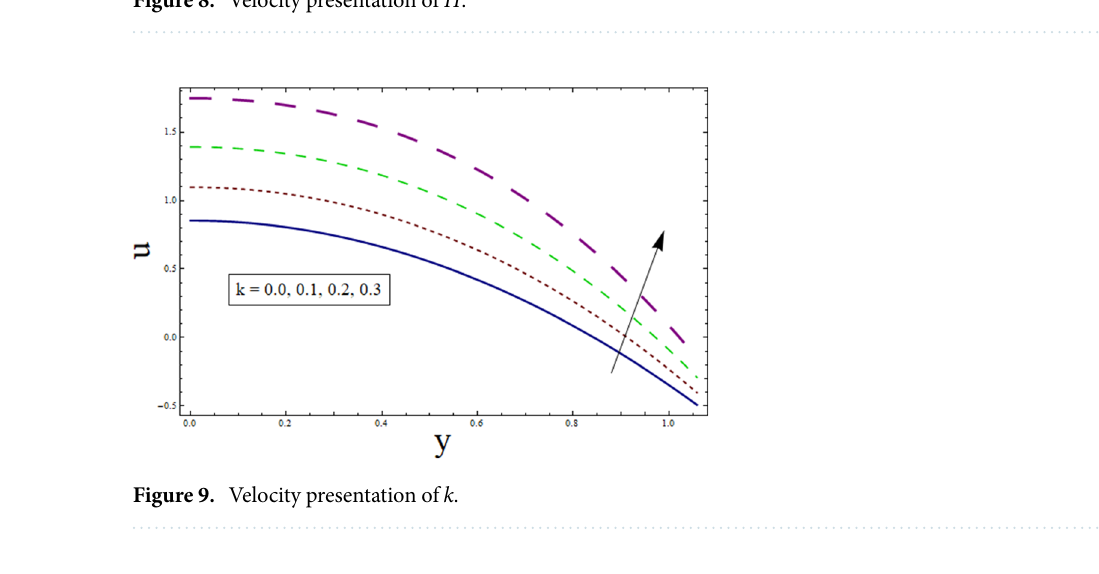
Figure 8. Velocity presentation of H .